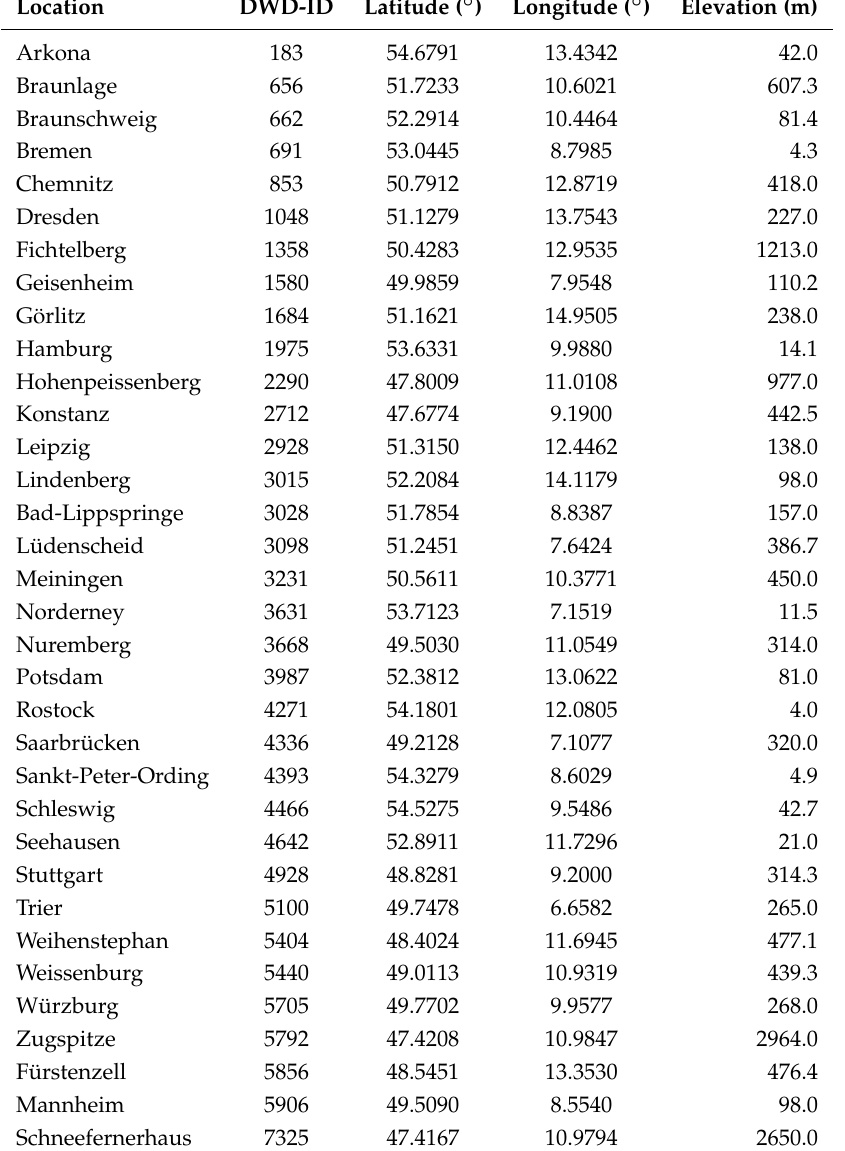
Table A2. List of DWD pyranometer